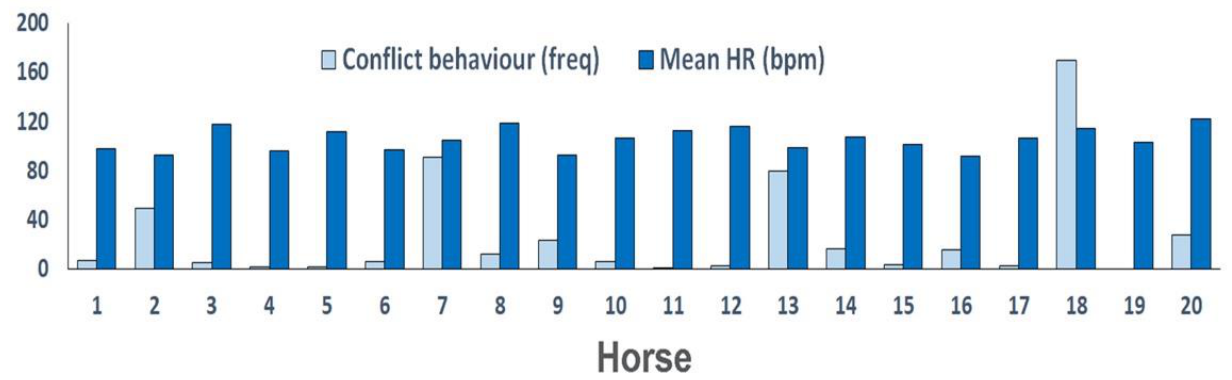
Figure 3. On the vertical axis, frequency of conflict behaviors (light blue columns) and mean HR (dark blue columns) during the riding test for 20 rider-horse combinations shown on the horizontal axis. Table 1. Spearman rank order correlation coefficient and p value. Bolded values indicate statistically significant correlations ( p < 0.05). Italicized values indicate a trend towards significance ( p > 0.05 < 1.0) (n = 20).